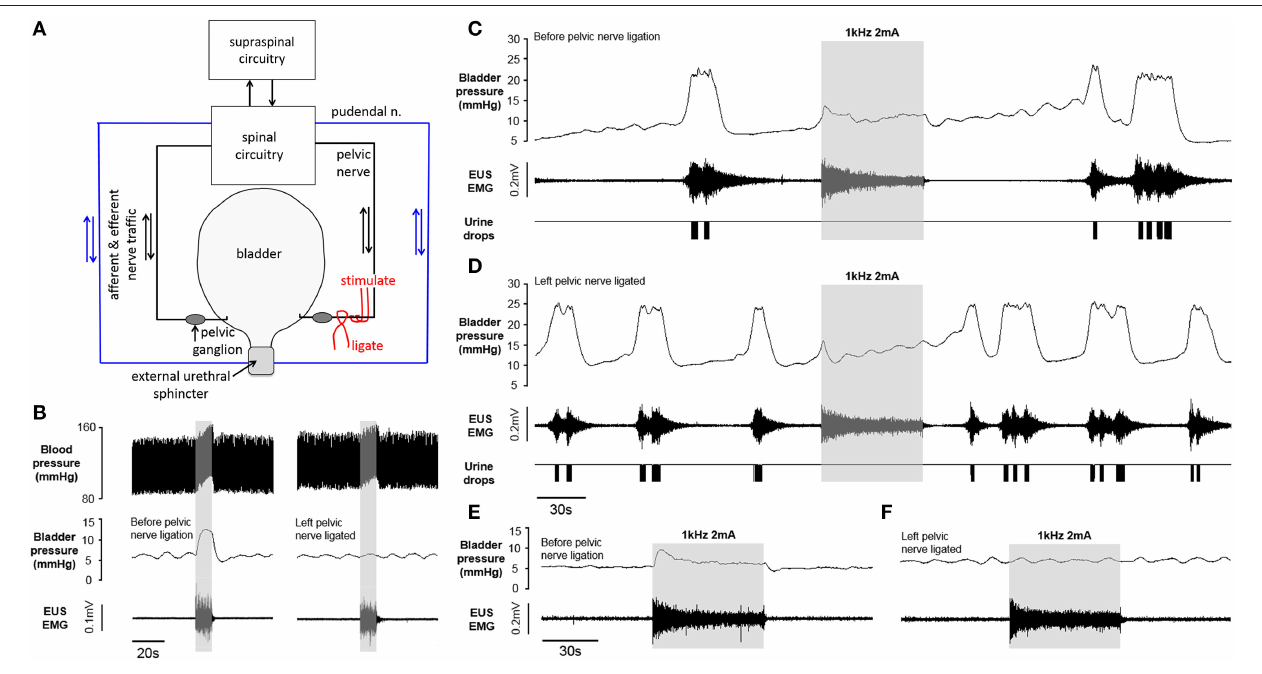
FIGURE 7 | (A) Schematic representation of experiments incorporating ipsilateral pelvic nerve ligation. (B) Contractile response of the bladder to low frequency stimulation of pelvic nerve (10Hz, 2mA, 1ms pulse width, grey panel) abolished after ipsilateral pelvic nerve ligation. EUS EMG and arterial pressor responses unaffected after nerve ligation. (C,D) voiding inhibited during high frequency pelvic nerve stimulation (2mA 1kHz sinusoidal, grey panel) after ligation of the distal ipsilateral preganglionic pelvic nerve. (E,F) Sustained tonic EMG activity evoked by pelvic nerve stimulation during the filling phase before (E) and after (F) ipsilateral pelvic nerve ligation. The transient ‘on-response’ in bladder pressure (E) was not observed following ligation (F)